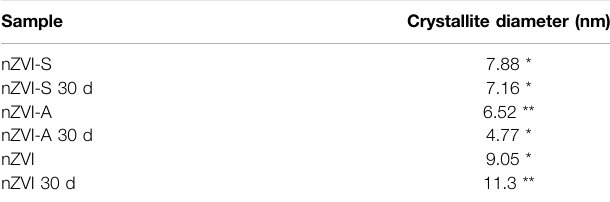
TABLE 2 | Average crystallite diameter according to Scherrer ’ s equation. * Crystallographic plane (1 1 0) and ** (3 1 1).